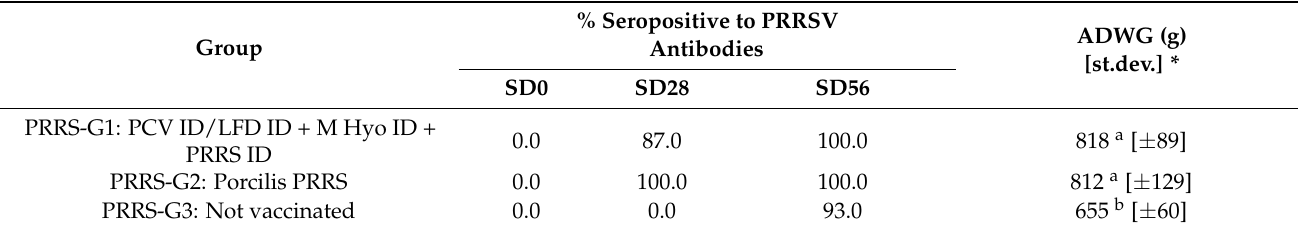
Table 1. Seropositivity to PRRSV pre-vaccination (SD0), pre-challenge (SD27) and end of study (SD56), and average daily weight gain post-challenge (SD27–SD56).